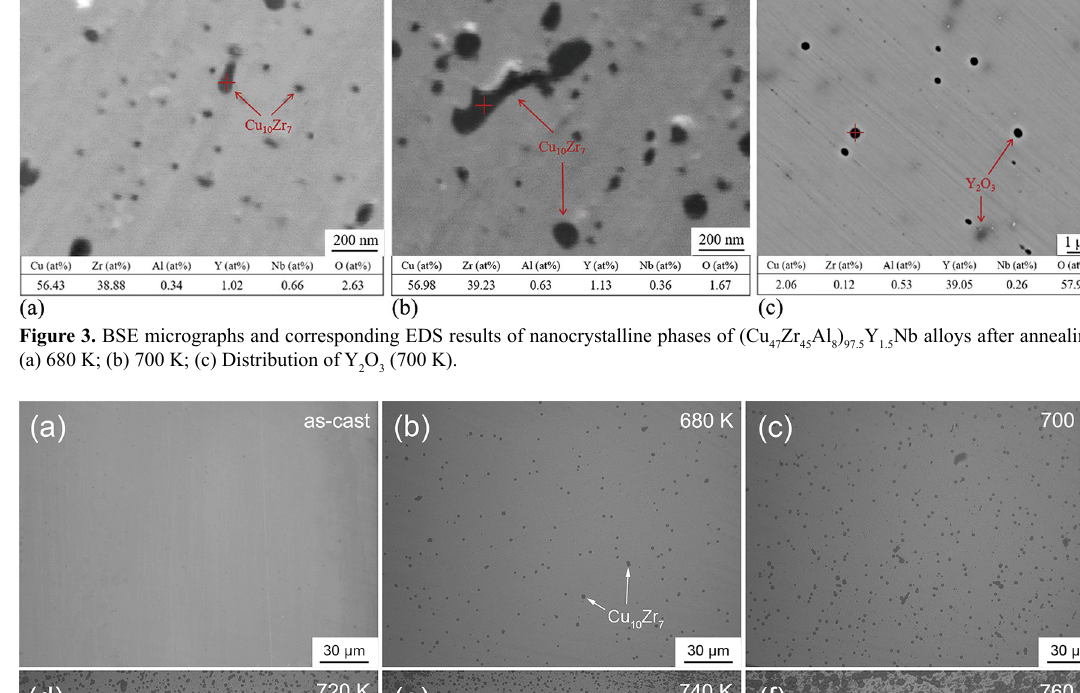
Figure 4. OM micrographs of (Cu K; (d) 720 K; (e) 740 K; (f) 760